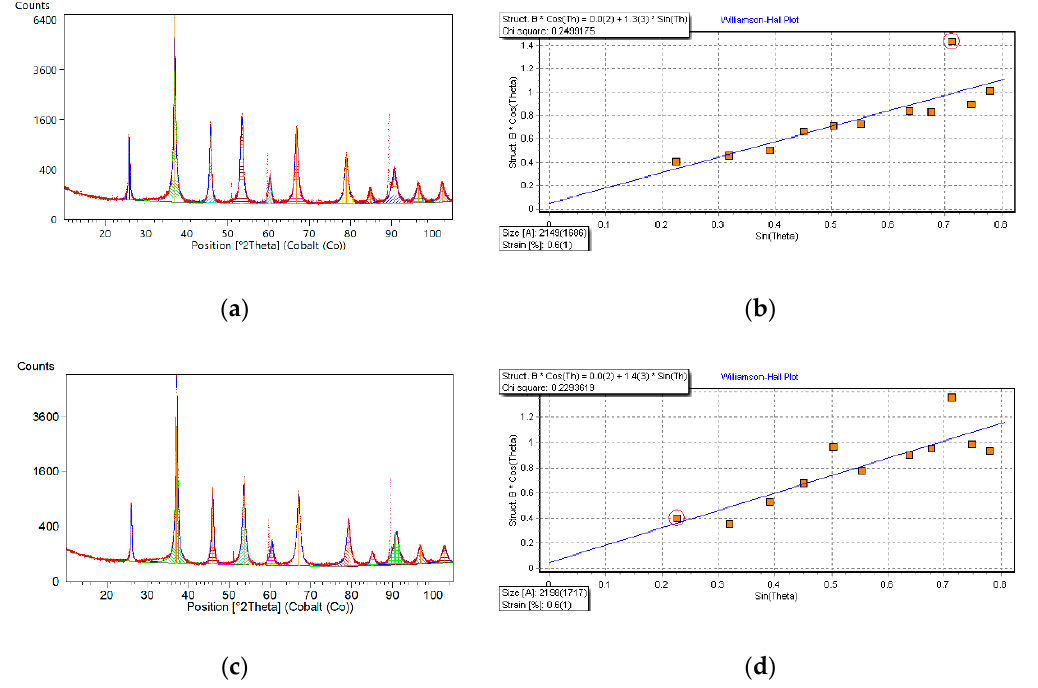
Figure 1. ( a ) X-ray diffraction pattern of the “upgraded” ( x = 5-4-3) sol-gel deposited BST thin film on the stainless-steel substrate. ( b ) Williamson-Hall plot of the “upgraded” ( x = 5-4-3) BST thin film. ( c ) X-ray diffraction pattern of the “downgraded” ( x = 3-4-5) BST thin film on the stainless-steel substrate. ( d ) Williamson-Hall plot of the “downgraded” ( x = 3-4-5) BST thin film.